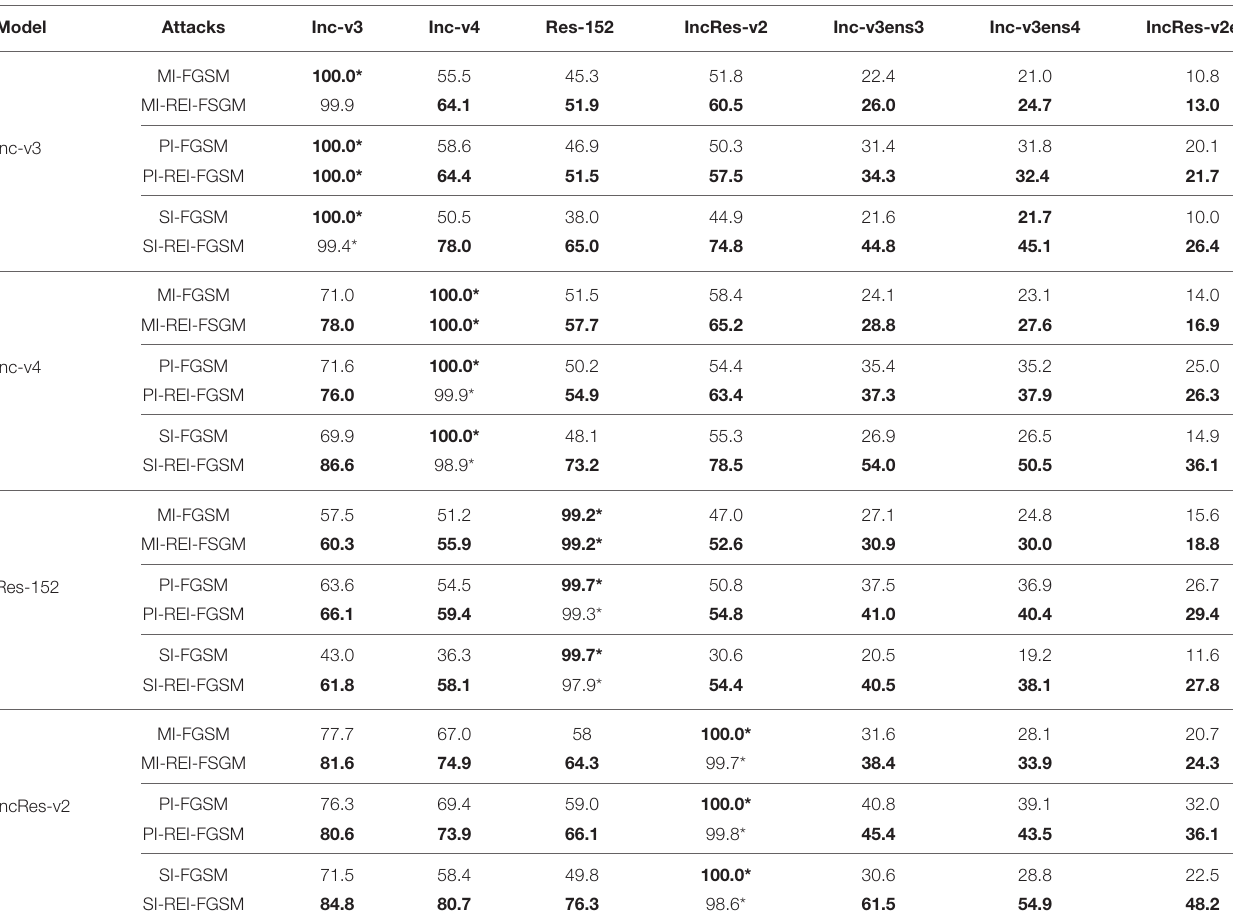
TABLE 3 | The success rate(%) of non-targeted attacks of seven models. Model